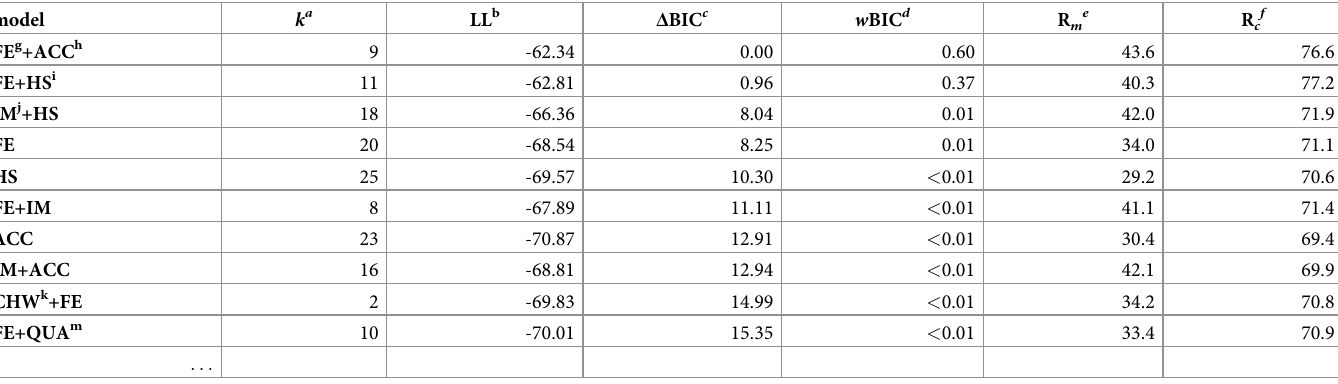
Table 2. Generalised linear mixed-effects models (only 10 top-ranked models according to w BIC c shown) of the highest-ranked variable from each theme (1. avail- ability of family planning, 2. quality of family planning, 3. education, 4. religion, 5. socio-economics) in relation to variation in fertility among 46 low- and middle- income